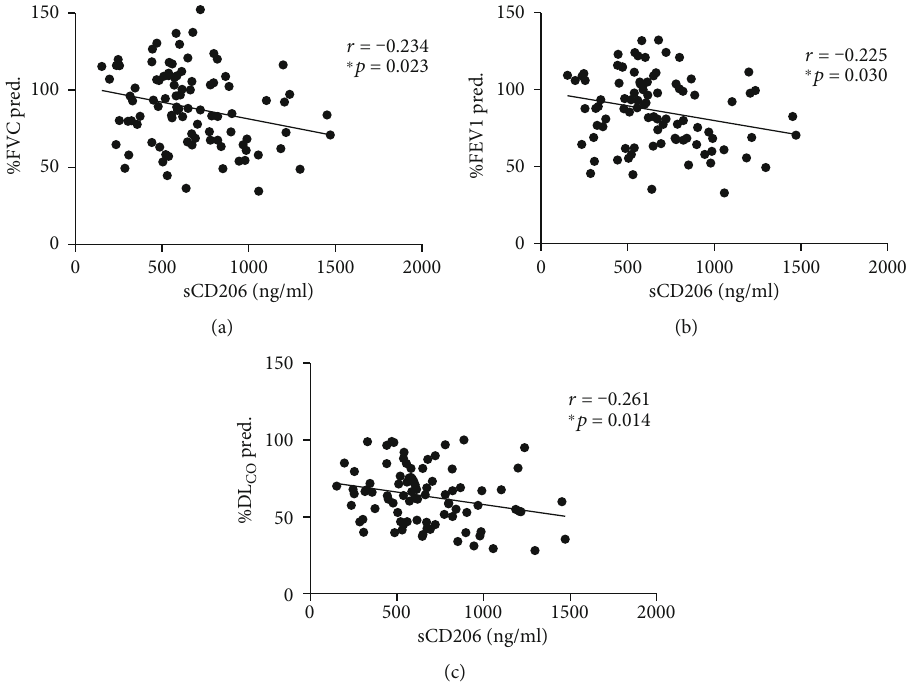
Figure 4: The correlation between sCD206 levels and PFTs in patients with DM. (a) sCD206 levels were negatively correlated with %FVC in patients with DM. (b) sCD206 levels were negatively correlated with %FEV1 in patients with DM. (c) sCD206 levels were negatively correlated with %DL in patients with DM. sCD206: soluble CD206; DM: dermatomyositis; PFTs: pulmonary function tests; %FVC: percent predicted CO forced vital capacity; %FEV1: percent predicted forced expiratory volume in one second; %DL di ff usion capacity.